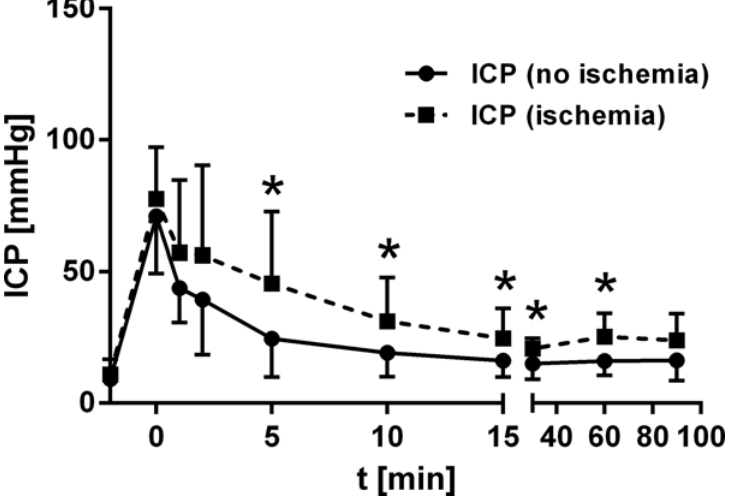
Fig 4. Course of ICP dependent on occurrence of territorial ischemia. ICP-levels (5 min to 90 min after SAH) differ significantly dependent on occurrence of ischemia ( * p < 0.05) with higher ICP-levels observed in cases with territorial